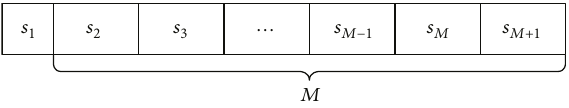
Figure 2: Information carried by individuals in the algorithm.